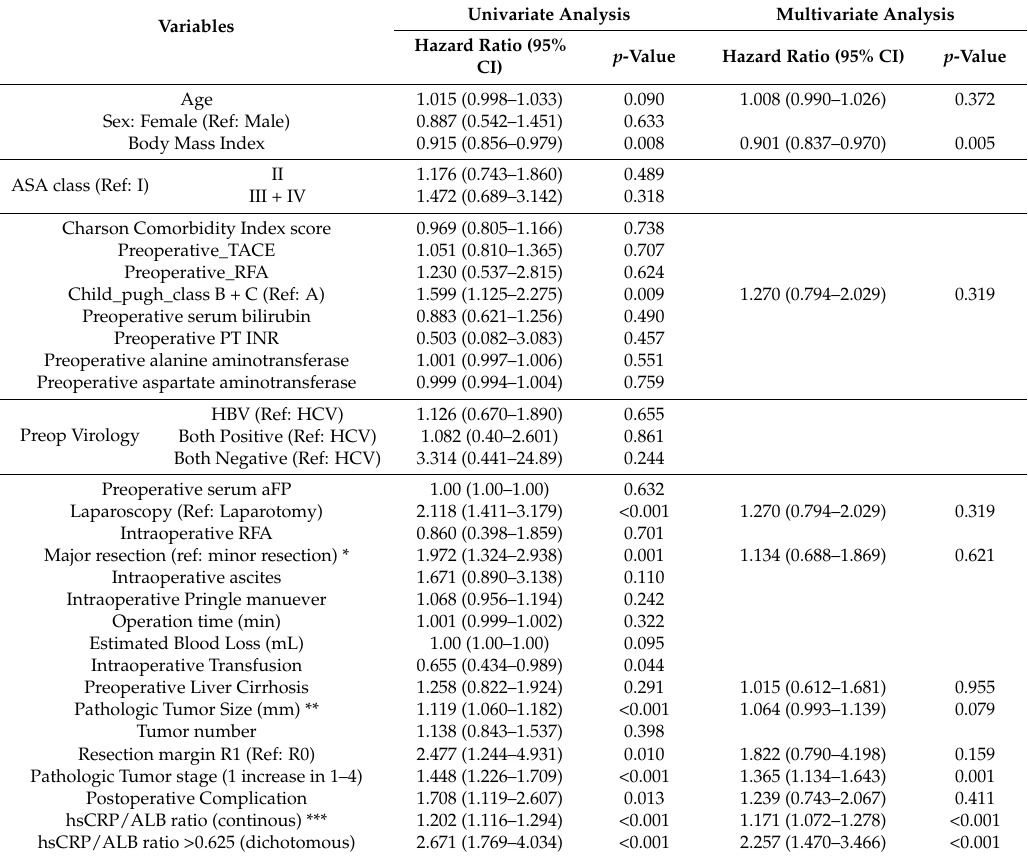
Table 2. Multivariate Cox regression analysis for mortality after HCC